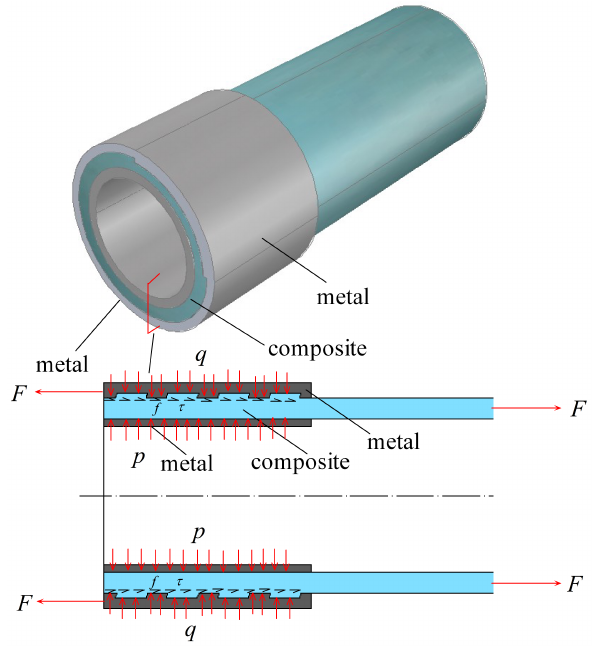
Figure 1: Composites pre-tightened tooth